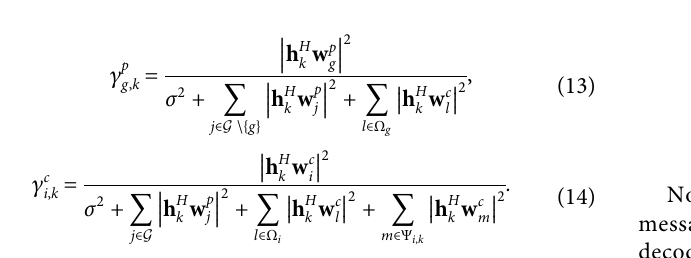
FIGURE2| AblockdiagramforanSICatuser1.Inthisexample,thecommonmessagesdecodedatuser1are Φ 1 (cid:3) {1,2,4}.Thedecodingorderat user1is π 1 (cid:3) {2, 4, 1}.